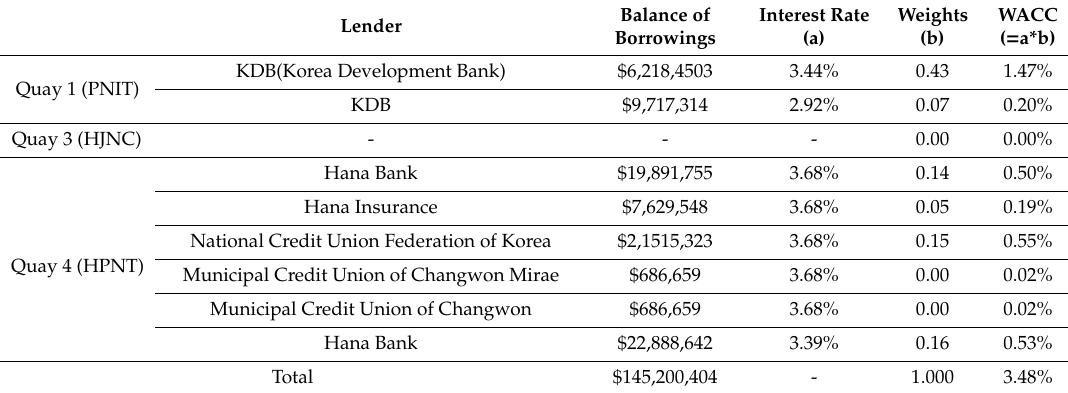
Table 1. Weighted average cost of capital of the three Terminal Operating Companies (TOCs).